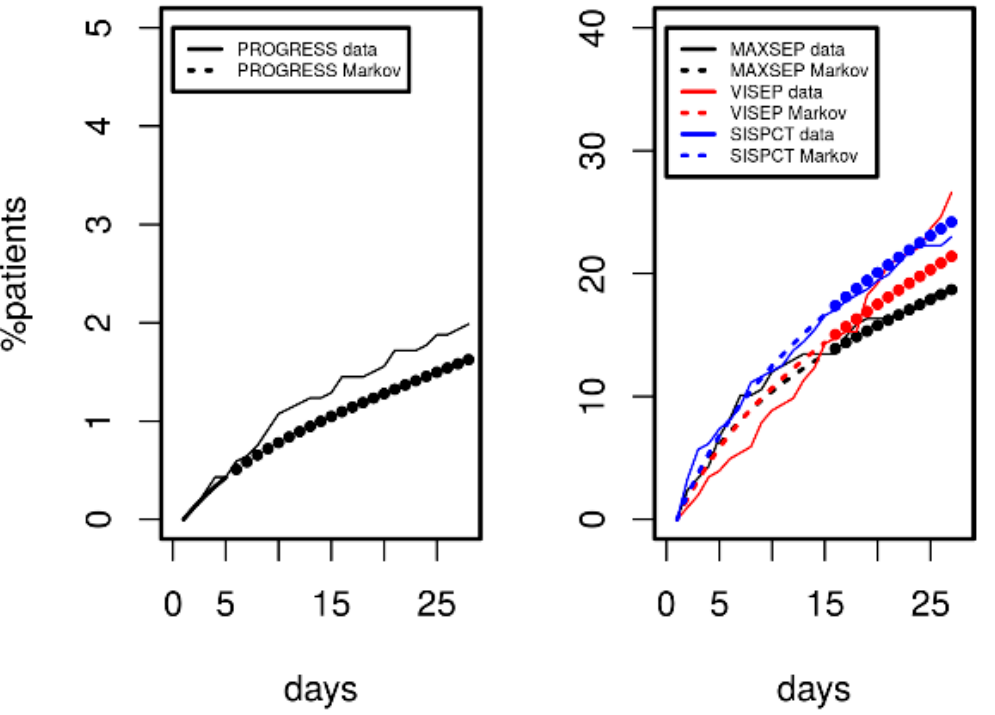
Figure 6. Comparison of mortality predicted by Markov modelling (dashed curves) in comparison to data of PROGRESS and the SepNet studies (solid curves). Agreement between model predictions and data not used for model calibration was excellent (filled circles). VISEP showed slightly inferior prediction.